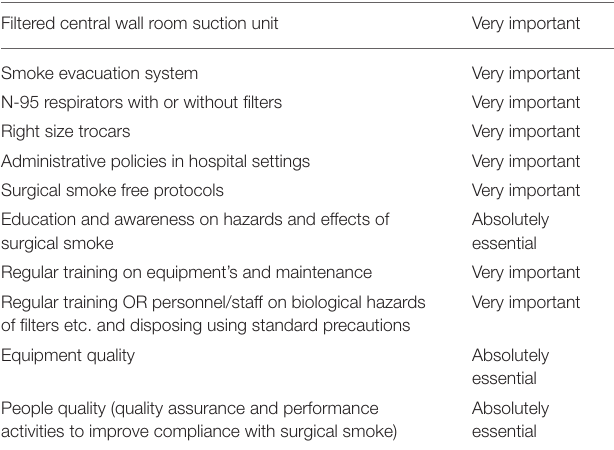
TABLE 2 | Recommendations in achieving smoke free OR